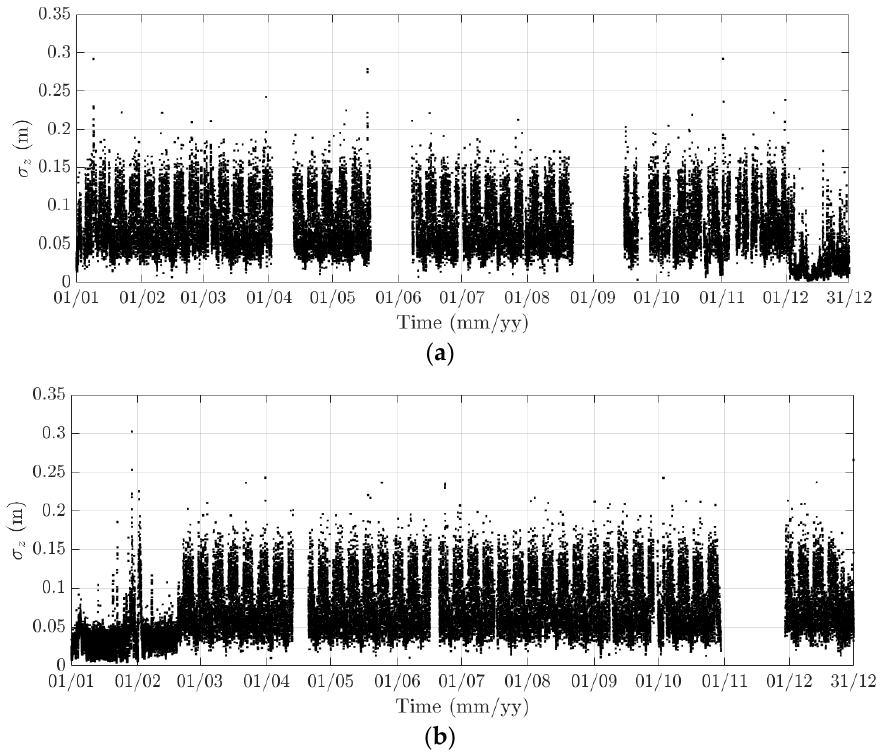
Figure 15. Variation of the 10 ‐ min standard deviation of the heaving response at the mid span of the FRB in ( a ) 2015 and ( b ) 2016.